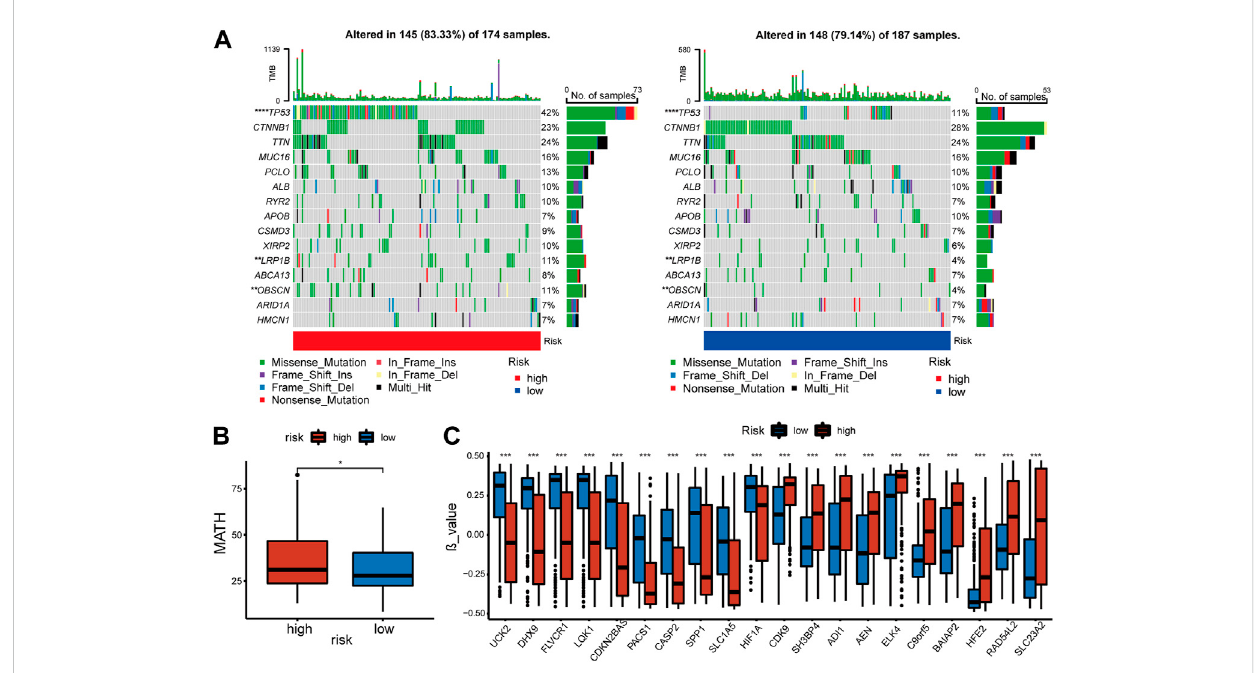
FIGURE 5 Features of mutation and methylation ofhigh- and low-risk groupsin theTCGA-cohort. (A) Diagramsof the15 mostsubstantiallychangedgenes in the high-risk and low-risk subgroups. (B) The MATH scores of HCC patients from high-risk and low-risk subgroups. (C) The top 10 genes with the most signi fi cant positive or negative β value difference in high- and low-risk